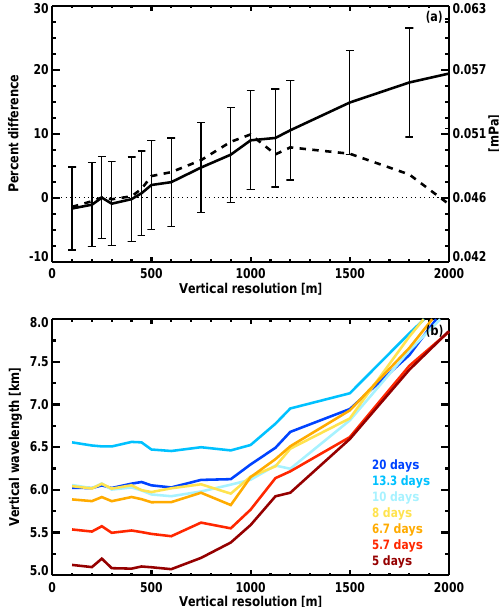
Figure 2. (a) Percent difference in the momentum fluxes from 250m vertical resolution (solid). The right axis gives the values of the flux. The dashed curve shows values for calculations done with L z set to the 250m resolution values. Standard errors, defined as the standard deviation divided by the square root of the effective sample size, are shown with bars for each tested resolution. (b) The variation of vertical length scale as a function of vertical resolution, shown here for each analyzed wave